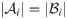
Illustrations of overlap profiles.A: Overlap profiles of WAP (blue) and DEG (green) scores across two gene expression data sets, where skin samples of SSc patients are compared to samples of non-SSc subjects. Values of |Ai|=|Bi| and |Ii| indicate sizes of gene sets and intersection between them corresponding to maxR values for WAP and DEG score profiles. B: The two summary statistics of an overlap profile.